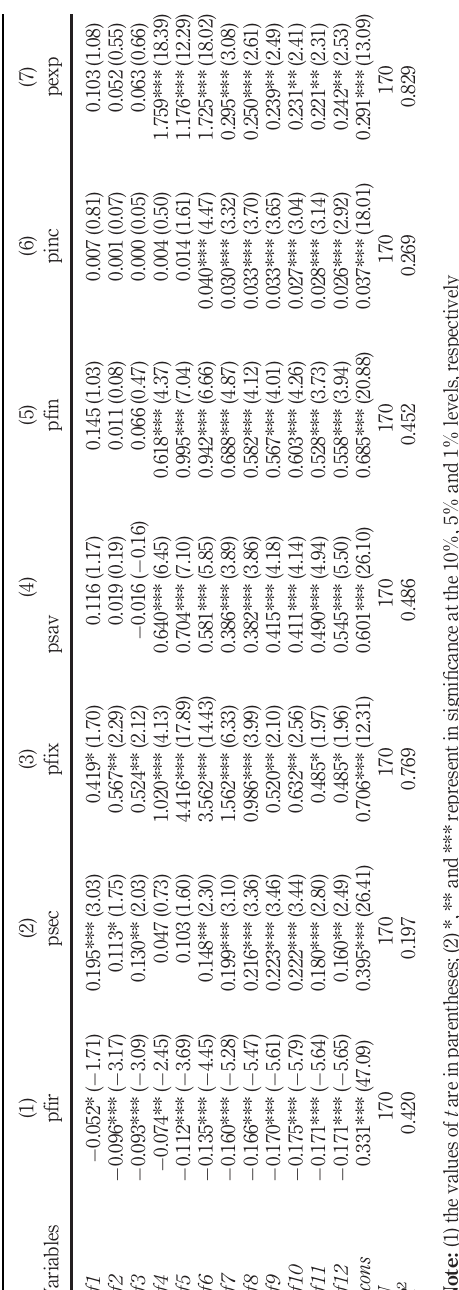
Table 7. Test results of the